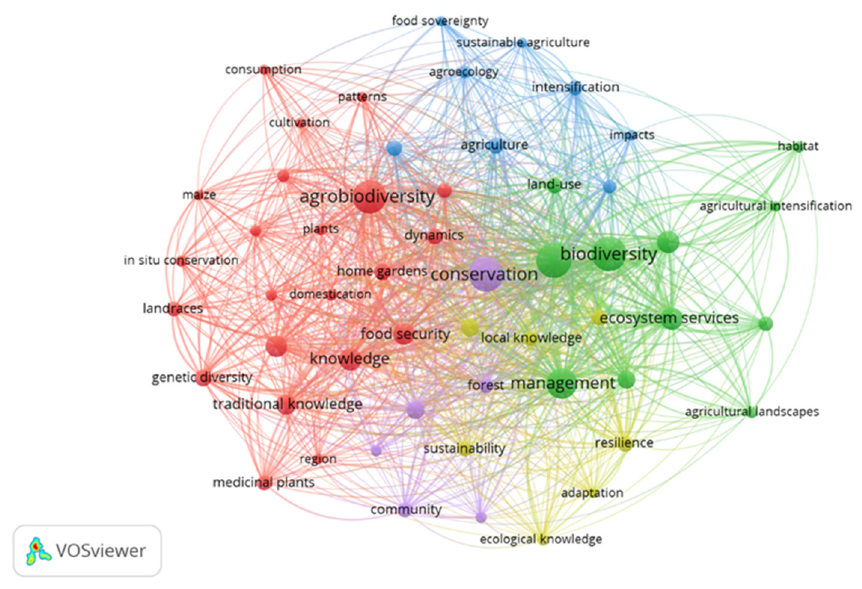
Figure 6. Co-citation knowledge map of keywords about the agrobiodiversity and traditional knowledge.